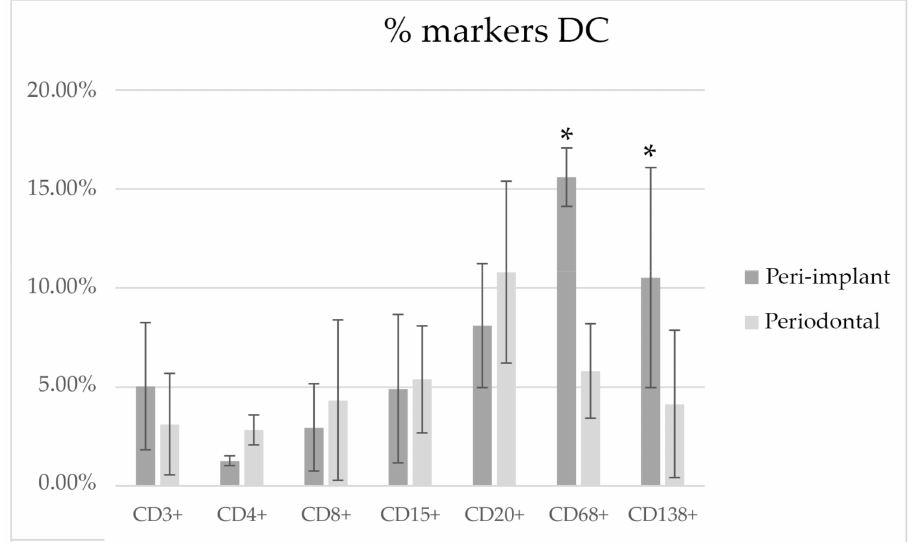
Figure 7. Markers counted with the DC technique. * Statistical difference evidenced between groups ( p <